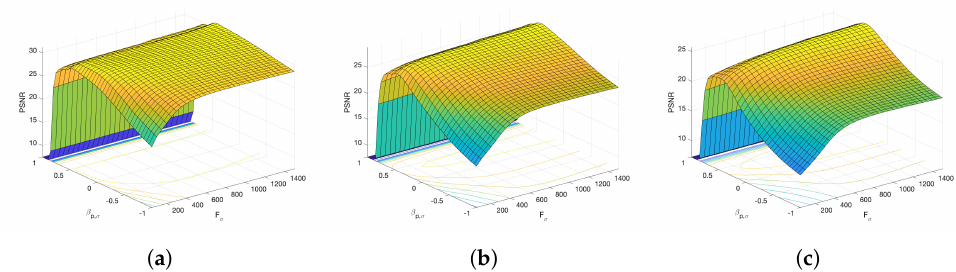
Figure 6. Dependence of the PSNR metric on the values F σ and β p , σ . Axial view corrupted with Gaussian σ and impulsive noise p . ( a ) σ = 10, p = 0.1. ( b ) σ = 20, p = 0.2. ( c ) σ = 30, p = 0.3.